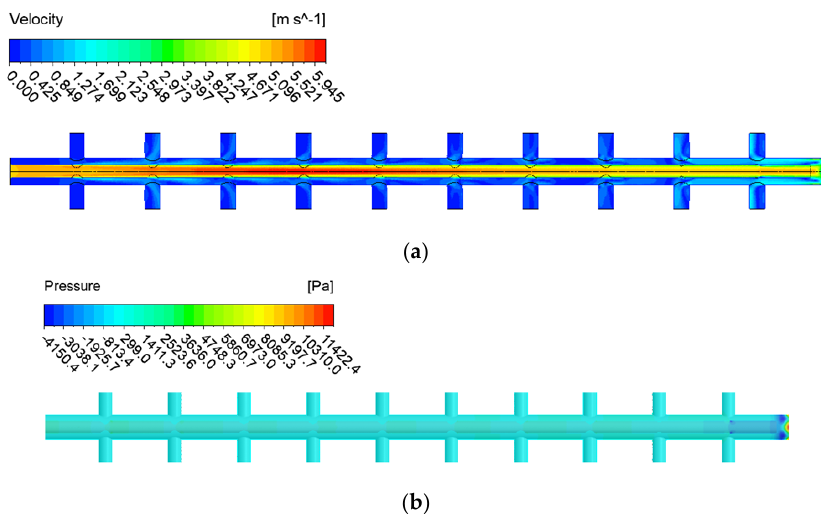
Figure 6. CFD simulation results for Case A (end open): ( a ) velocity contours; ( b ) pressure distribution contours.